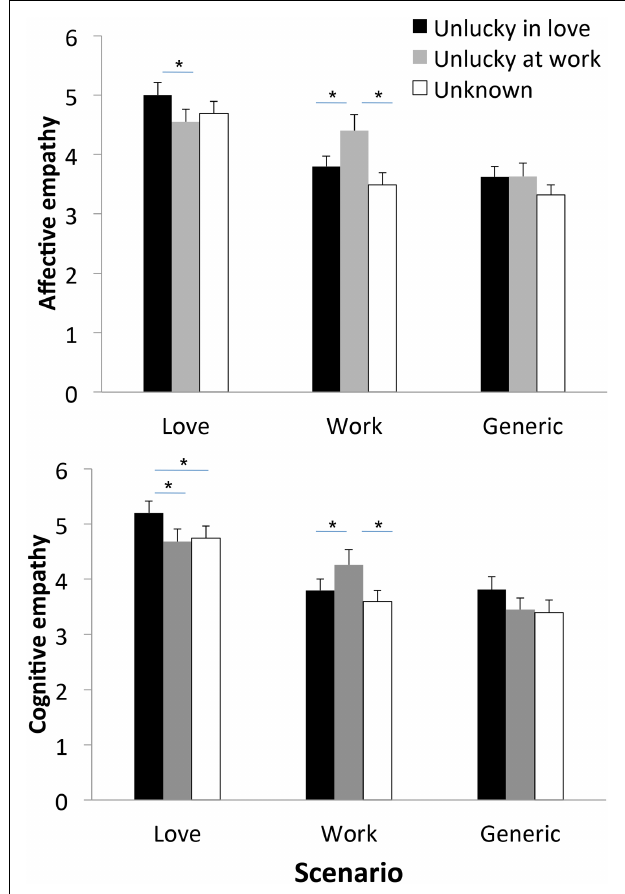
FIGURE 1 | Mean affective empathy scores (TOP panel) and cognitive empathy scores (BOTTOM panel) by type of scenario and character. Error bars indicate the standard error of the mean. * p <